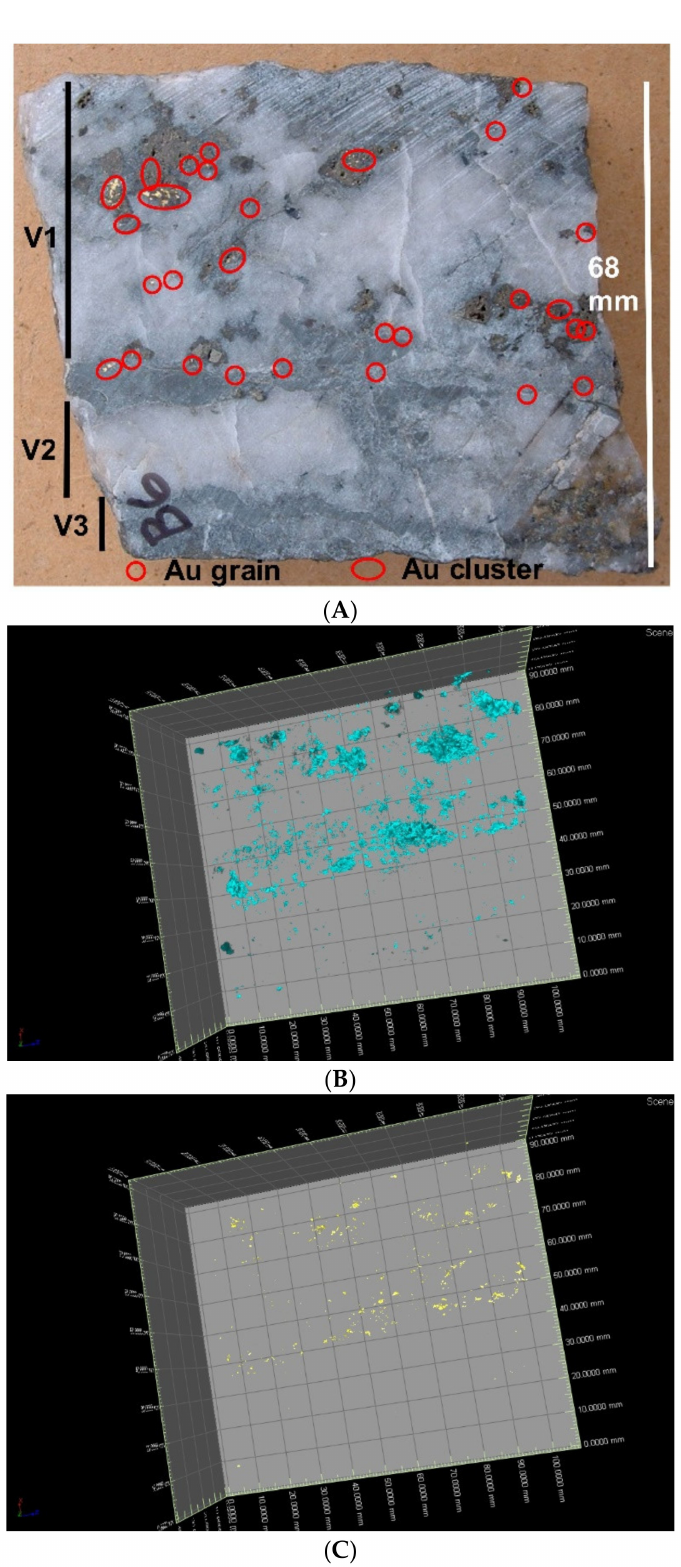
Figure 13. Sample B6, photograph and XCT images. The XCT images are viewed in same direction as the hand specimen photograph but are slightly rotated left hand down relative to hand specimen photograph. ( A ) Hand specimen photograph. Single gold particles (>500 µ m) circled in red, gold par- ticle clusters in red ovals. Most gold occurs in, or adjacent, sulphide psuedomorphs. ( B ) Distribution of sulphides through the sample. ( C ) Distribution of gold through the